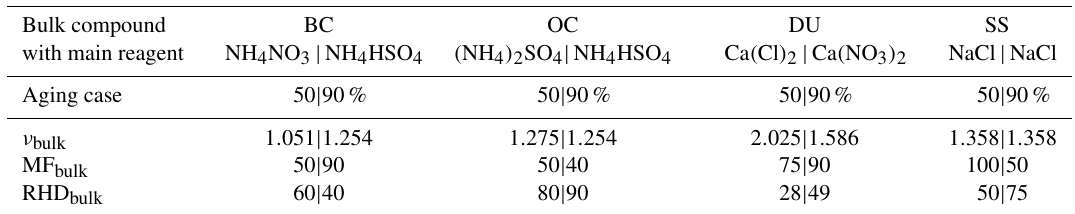
Figure 4. AOD and PM time series for 2000–2013 (monthly means): ISORROPIA II (ISO2) and EQSAM4clim (EQ4c) versus AERONET and EMEP observations (a) . Panel (b) shows the corresponding climatological year for the AOD and PM (14-year average). The two stations Harwell and Chilbolton (United Kingdom) lie well within one model grid box (51 ◦ N, 1 ◦ W). Table 2. Parameters for the different chemical aging levels of bulk species shown in Table 4 (Sect. 4.2). ν bulk ( − ) denotes the bulk water uptake coefficient, RHD bulk ( % ) the bulk water uptake threshold, and MF bulk ( % ) the mass fraction used for chemical aging of the bulk aerosol species. The main reagent that is assumed to determine the chemical aging (through implicit coating and water uptake) is included below the bulk species. The values have been empirically determined by numerous model applications and a very comprehensive model evaluation by the constraint to yield the best agreement of our EMAC version with independent model results and various observations. Key results of this evaluation cycle are shown in Sect. 3; additional results will be presented